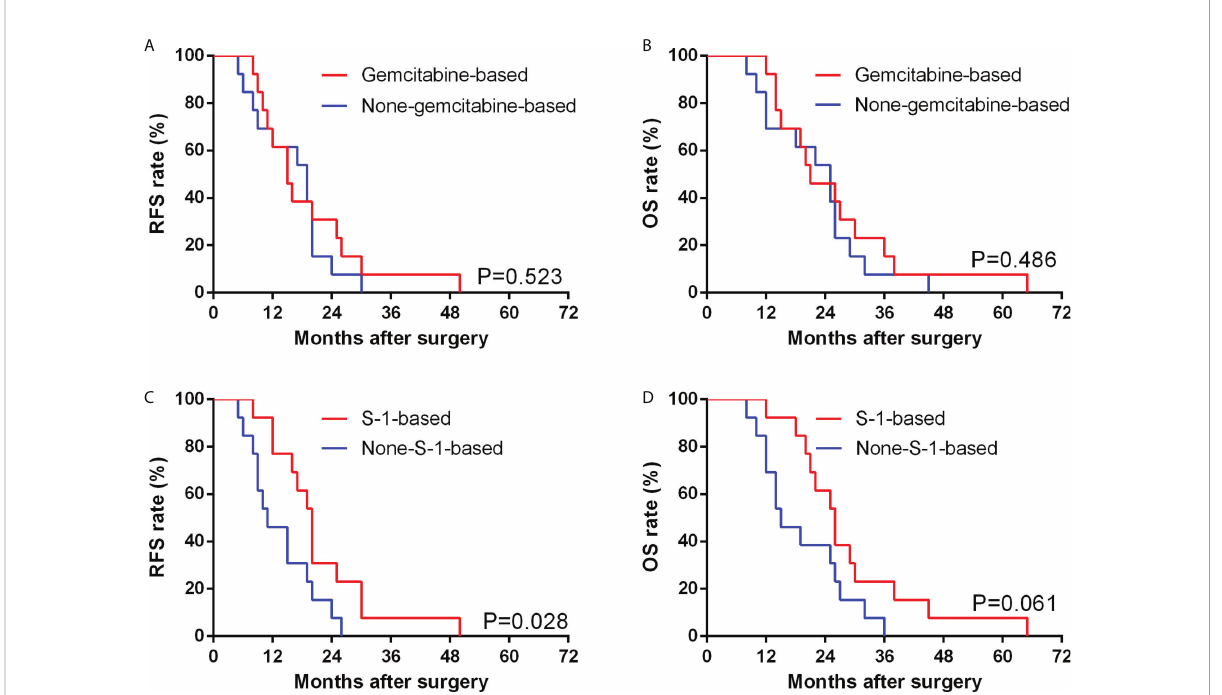
FIGURE 4 Comparison of RFS (A) and OS (B) between GBSC patients who underwent curative surgery with gemcitabine-based chemotherapy and non- gemcitabine-based chemotherapy by Kaplan − Meier analysis; Comparison of RFS (C) and OS (D) between GBSC patients who underwent curative surgery with S-1-based chemotherapy and non-S-1-based chemotherapy by Kaplan − Meier analysis. (Among the GBSC patients who underwent curative surgery, 26 received postoperative chemotherapy, including 3 of GX combination, 3 of GP combination, 2 of AG combination, 5 of GS combination, 8 of S-1 monotherapy and 5 of Xeloda